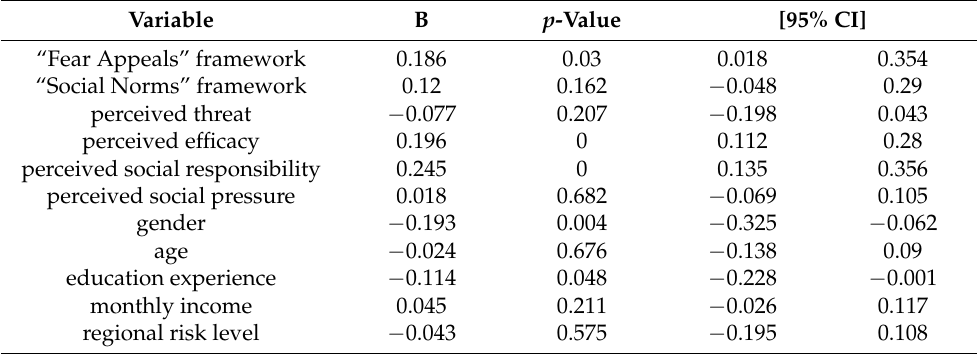
Table A8. Linear regression model of vaccination recommendation on risk communication frame- works and mediators, n =